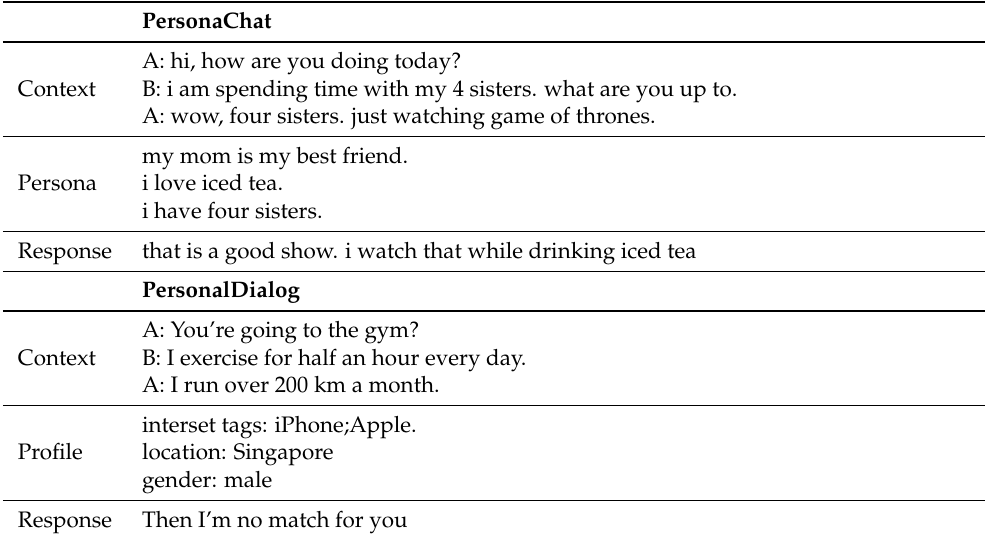
Table 1. The examples of PersonaChat and PersonalDialog.